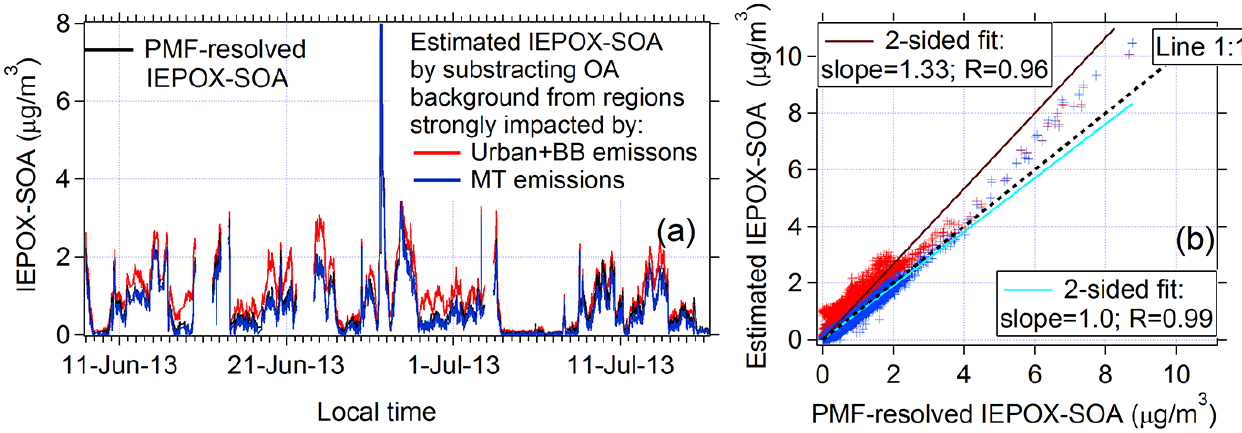
Figure 8. (a) Time series of IEPOX-SOA PMF and estimated IEPOX-SOA based on C 5 H 6 O + for the SOAS data in SE US. Two different estimates of background C 5 H 6 O + are shown, using values from regions strongly impacted by urban and biomass-burning emissions vs. regions with strong monoterpene emissions. (b) Scatter plot of estimated IEPOX-SOA vs. IEPOX-SOA PMF . Note that the largest IEPOX- SOA plume on 26 June 2013 had a slightly higher f OA of 24‰, resulting in a slight overestimation of IEPOX-SOA for those data C 5 H 6 O